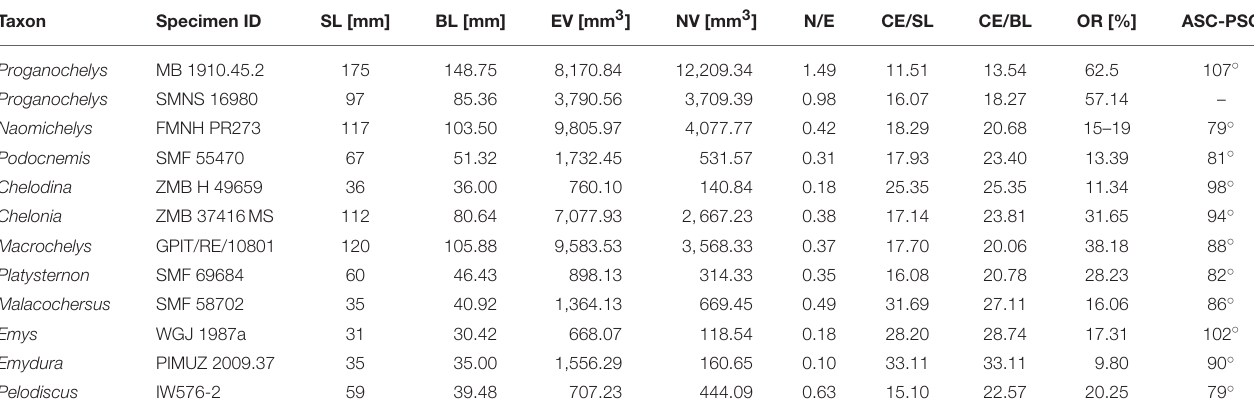
TABLE 1 | Measurements and ratios for sampled